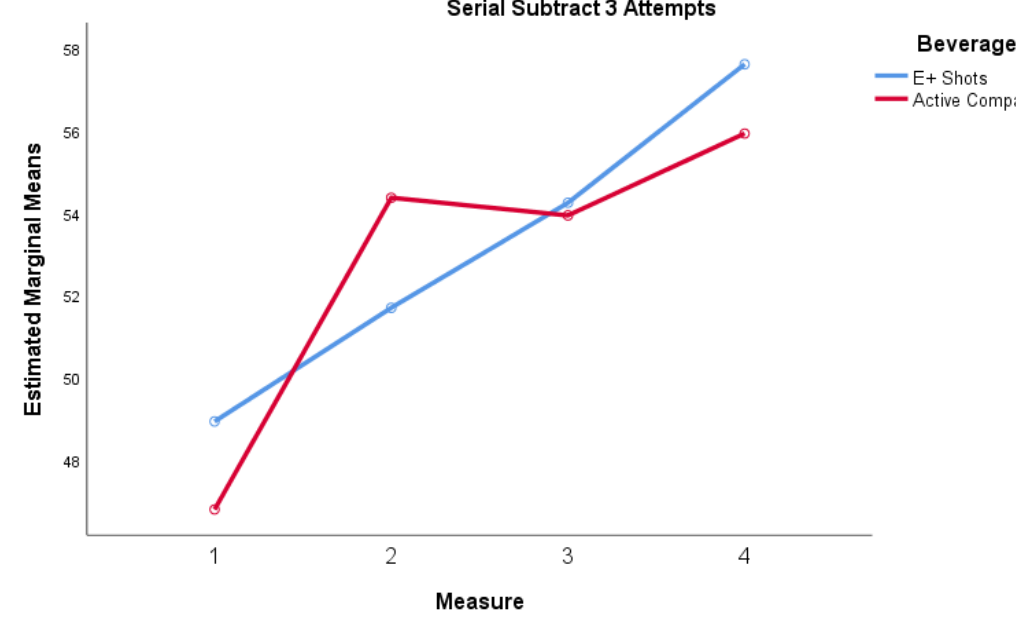
Figure 5. Serial subtraction 3 attempts for e+ shot vs. active comparator (caffeine).